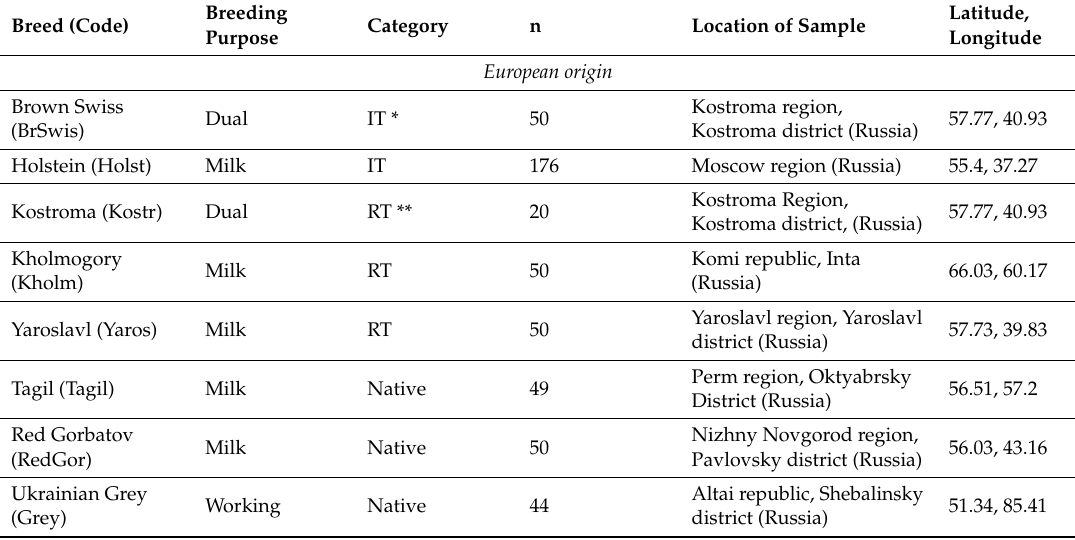
Table 1. Information on cattle